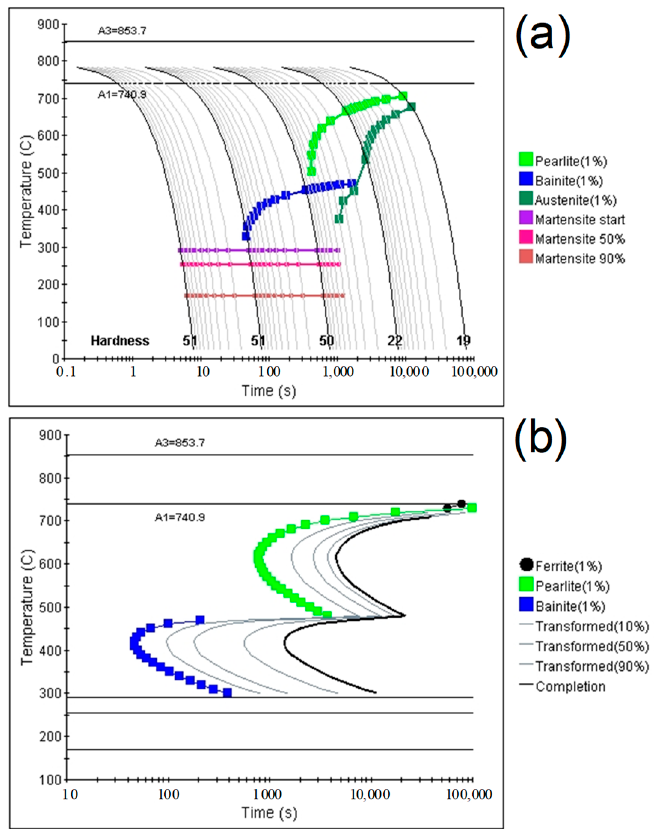
Figure 3. ( a ) CCT and ( b ) TTT intercritical diagrams calculated with JMatPro 8.0 using the chemical composition of the experimental steel after being recalculated considering the carbon content in austenite.